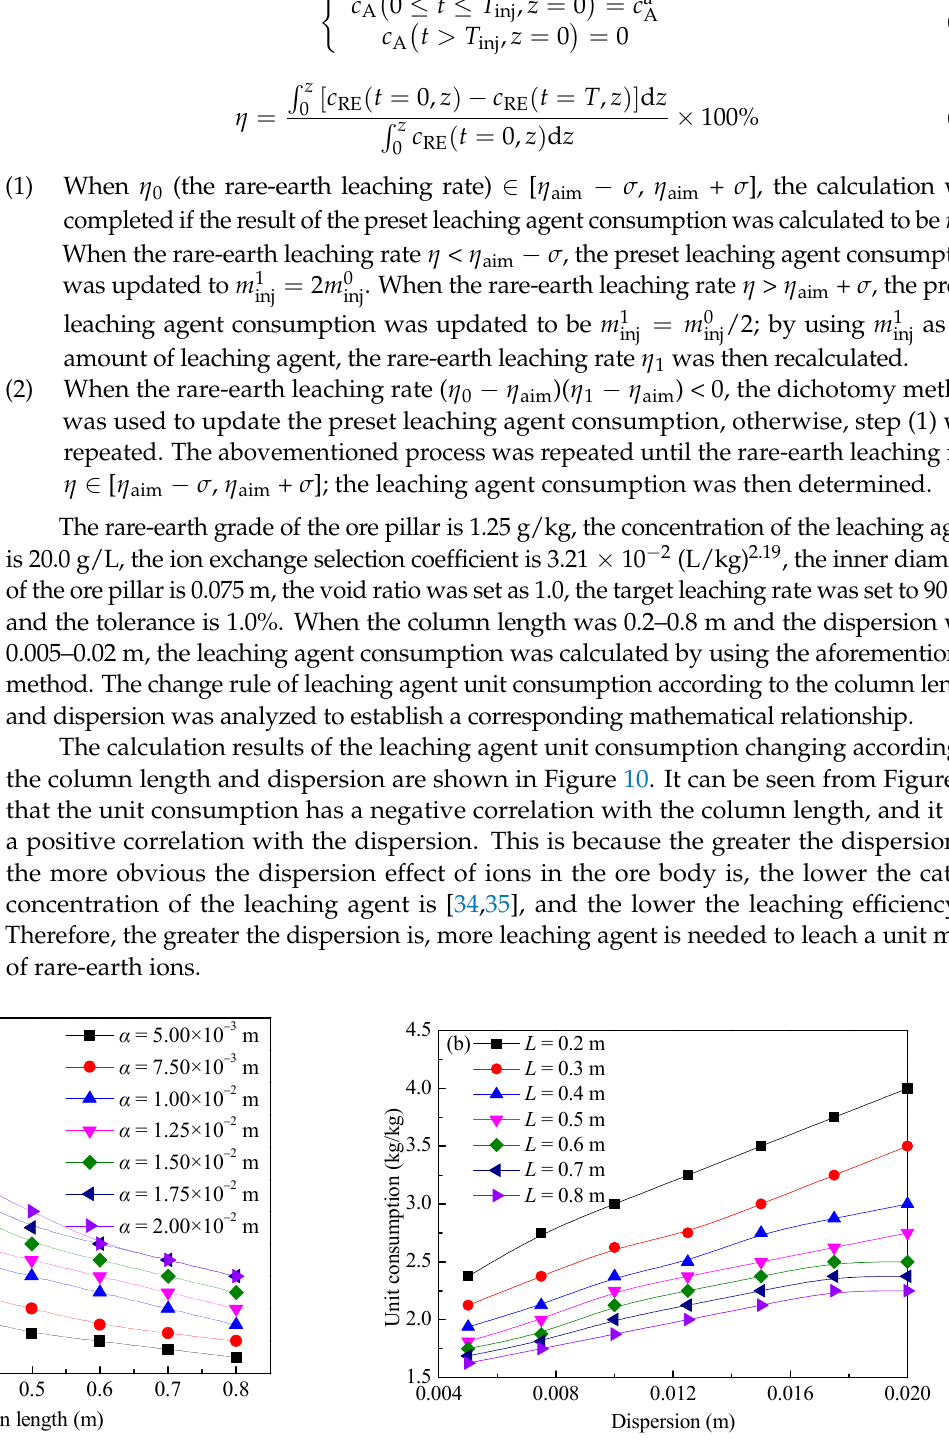
Figure 10. Relationship between the leaching agent unit consumption and dispersion and column length: ( a ) column length and ( b ) dispersion.